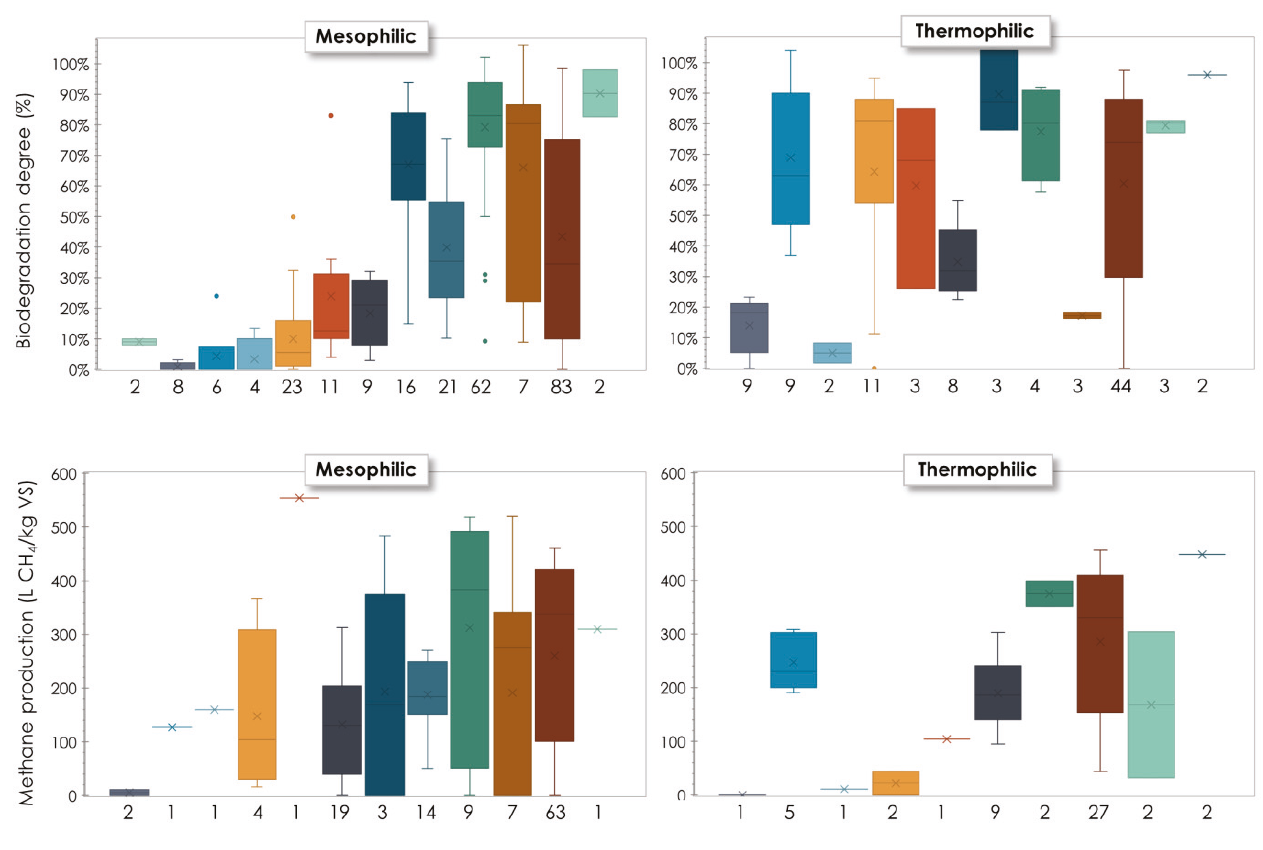
Figure 6. Average values ( × ) and range of variation (quartiles and min-max range) for the biodegrada- tion degree and methane production yield under mesophilic ( left ) and thermophilic ( right ) conditions. Dots represent the outliers. The values below each box indicate the number of data points